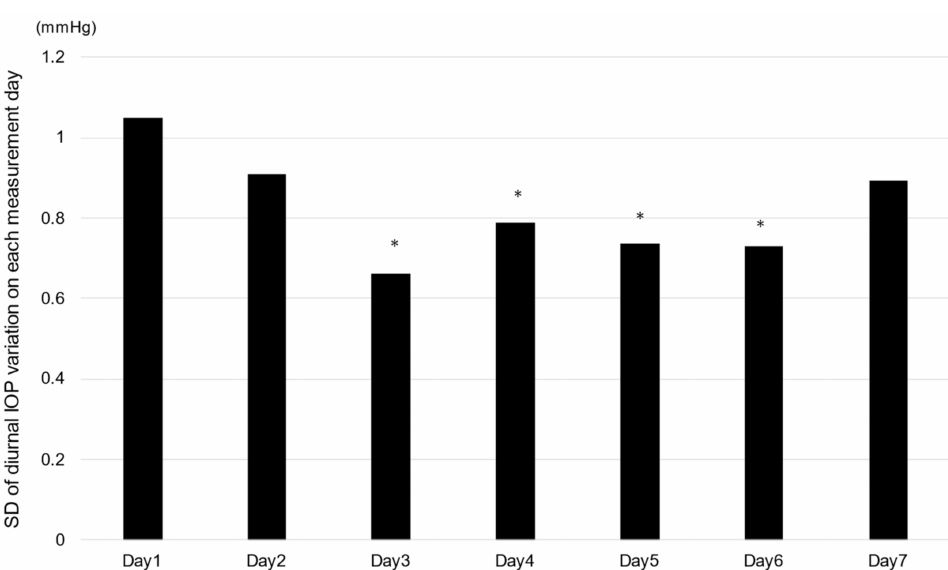
Figure 5. Fluctuation in the magnitude of diurnal IOP change. SD: standard deviation, * p < 0.05 vs. day 1, the Tukey–Kramer multiple comparison